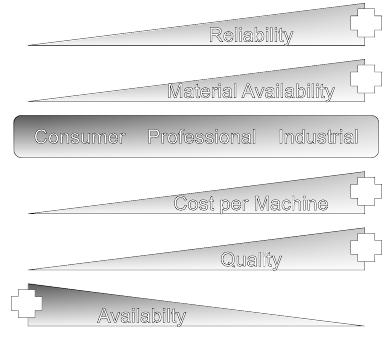
Figure 12. Audience classification and